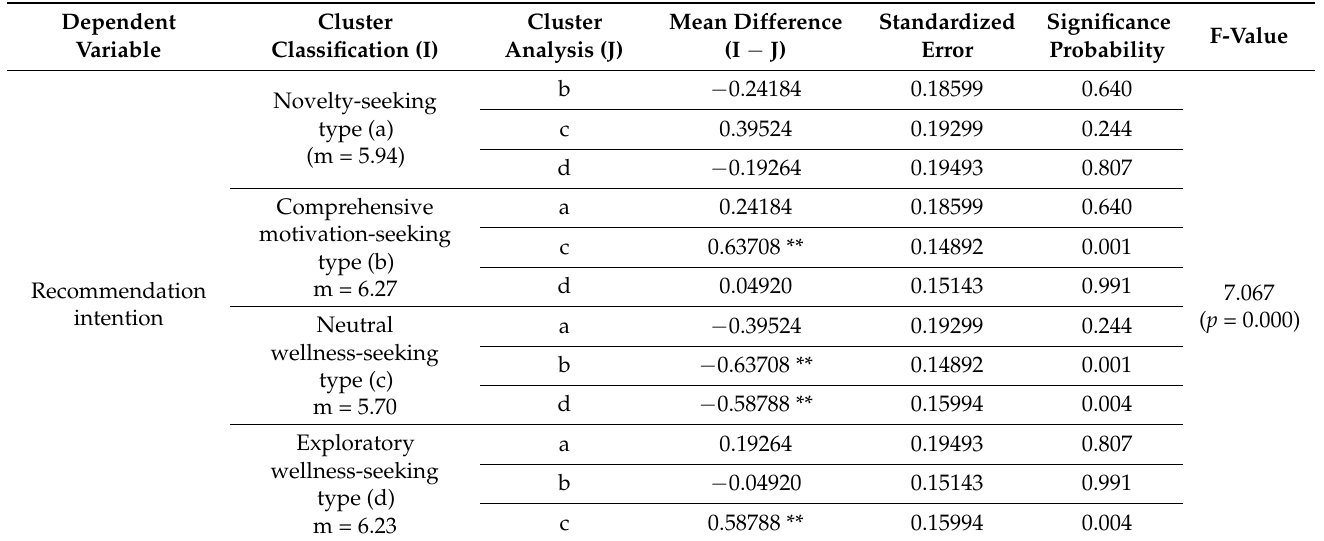
Table 15. Differences in means of recommendation intention among wellness tourism product participant